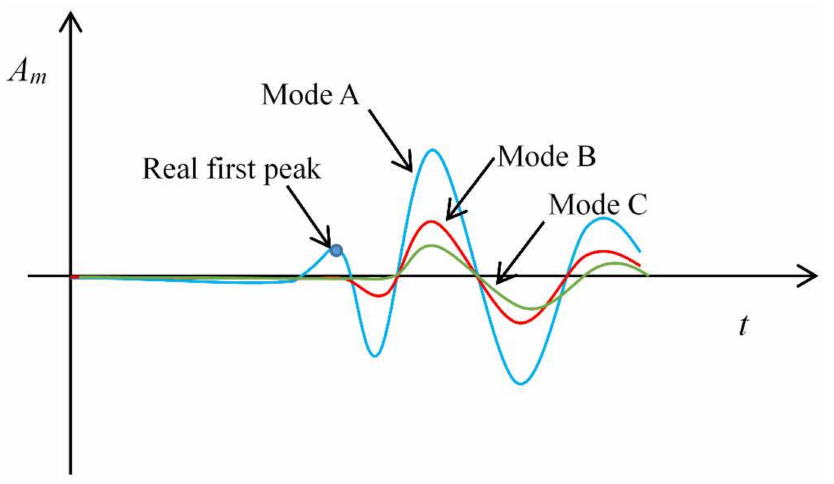
Figure 9. Three modes of received signals related to wave